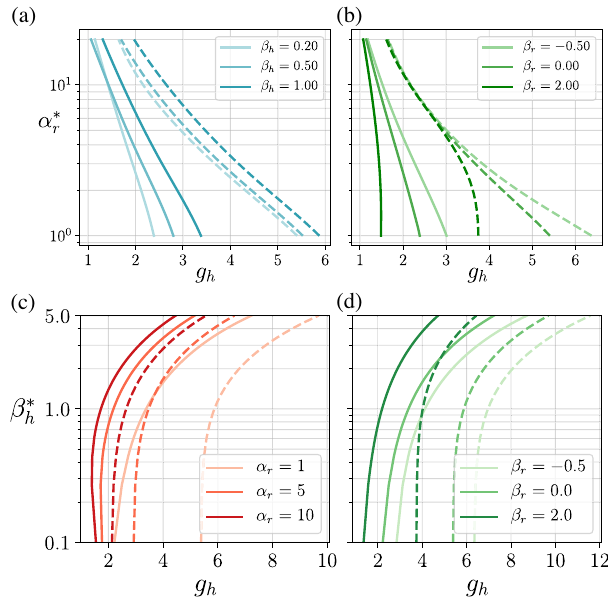
FIG. 13. How the biases alter the transition between stability and chaos. (a) Critical lines indicating boundaries for stability (solid lines) or marginal stability (dashed lines) for different values of β . (b) Similar to (a) but for different values of β . (c),(d) h r How the boundaries of stability (solid lines) or marginal stability (dashed lines) change as we vary α (c) or β r r